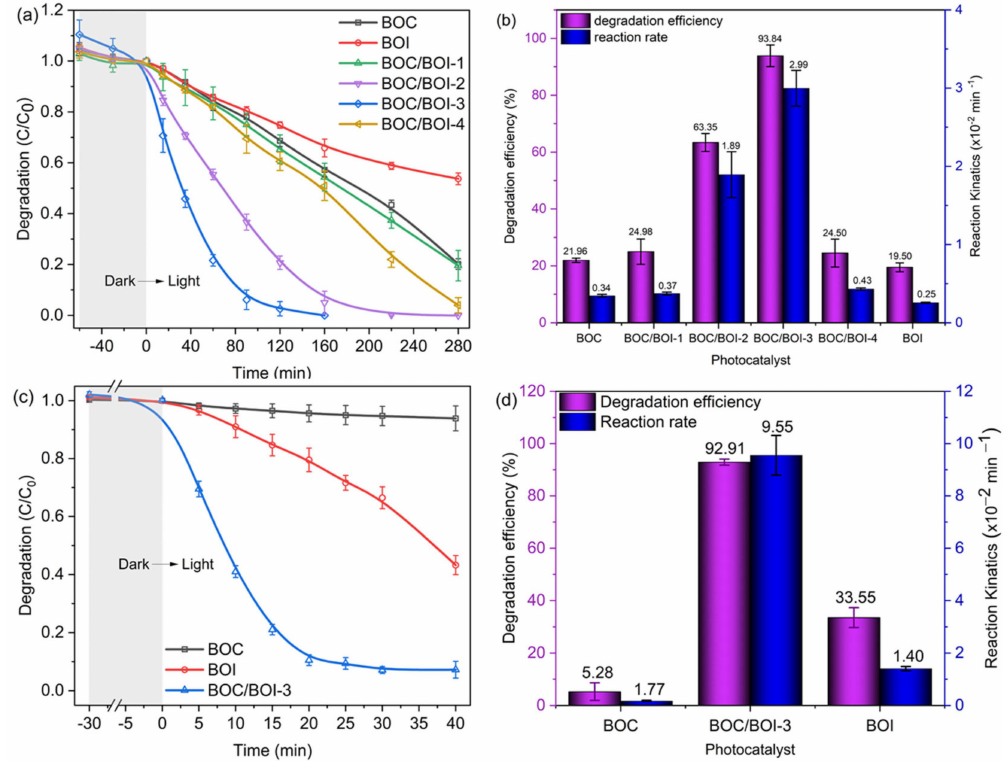
Figure 5. ( a ) Photocatalytic degradation of RhB and ( b ) degradation efficiency of RhB with the reaction rate constants employed by all samples; ( c ) Photocatalytic degradation of BPA and ( d ) its degradation efficiency with reaction rate constants employed by BOI, BOC and BOC/BOI-3